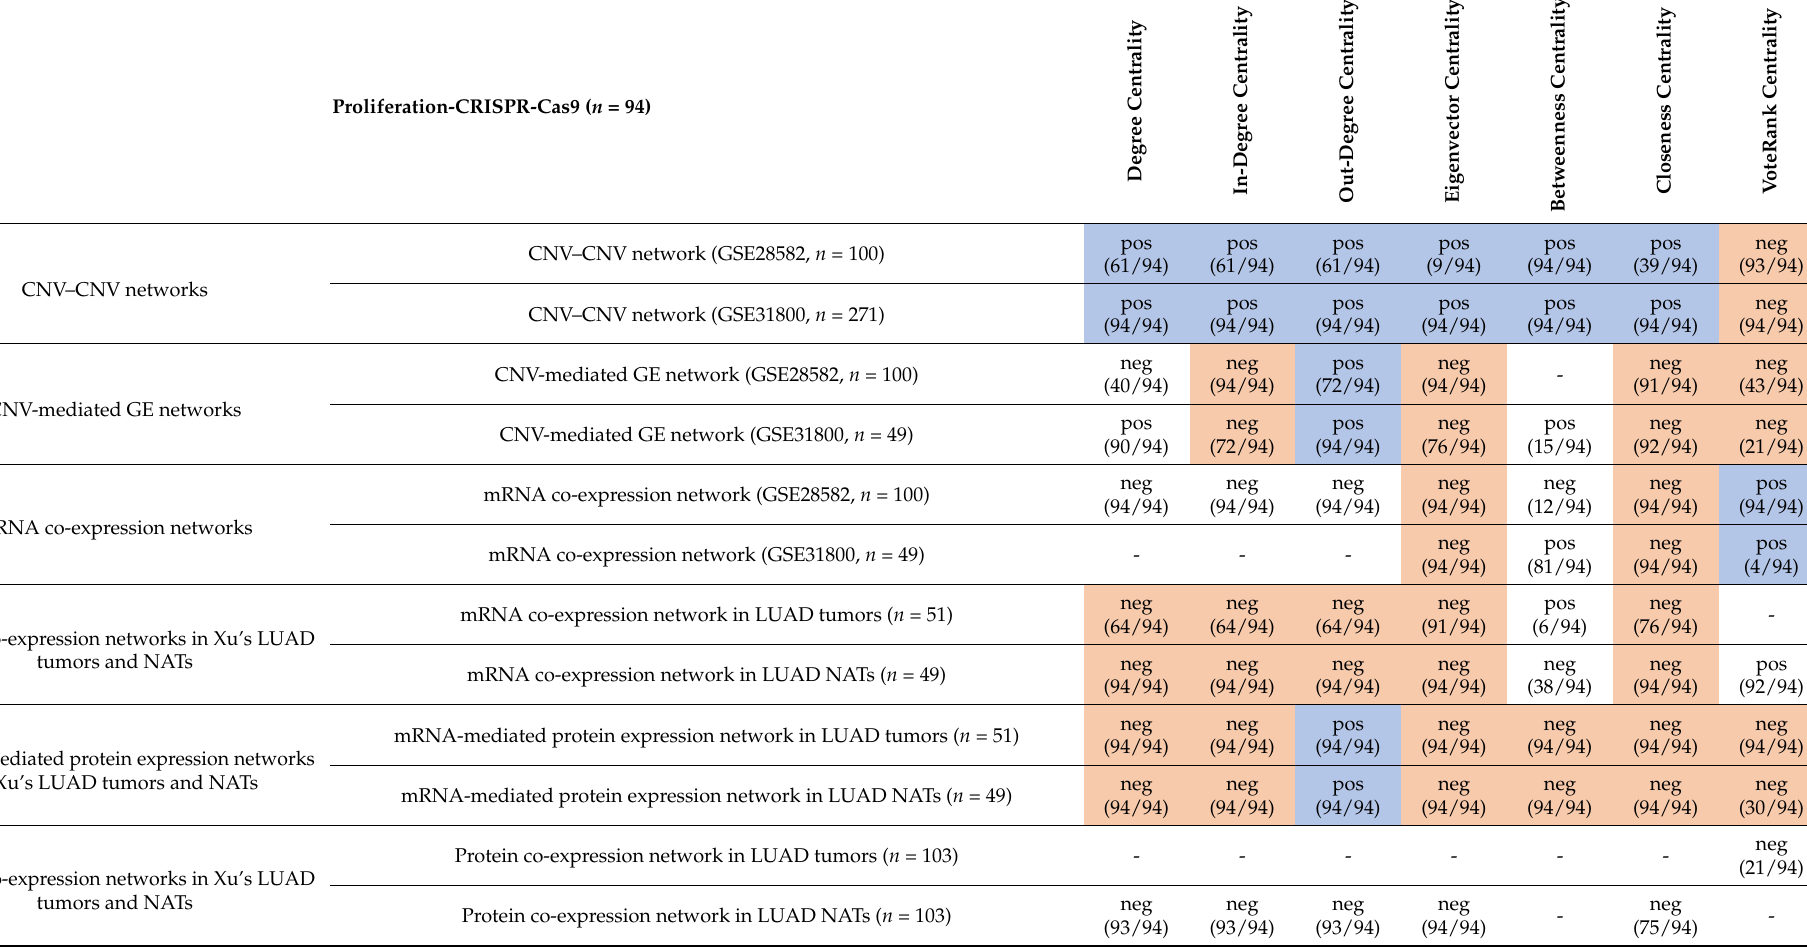
Table 4. Correlations of seven centrality metrics of selected networks with CRISPR-Cas9 dependency scores. pos: Pearson’s correlation coefficient r > 0 and p < 0.05; neg: r < 0 and p < 0.05; -: not significant. The numbers in parentheses showed the number of NSCLC cell lines with a significant correlation coefficient. The blue color indicates concordant positive correlations. The orange color indicates concordant negative